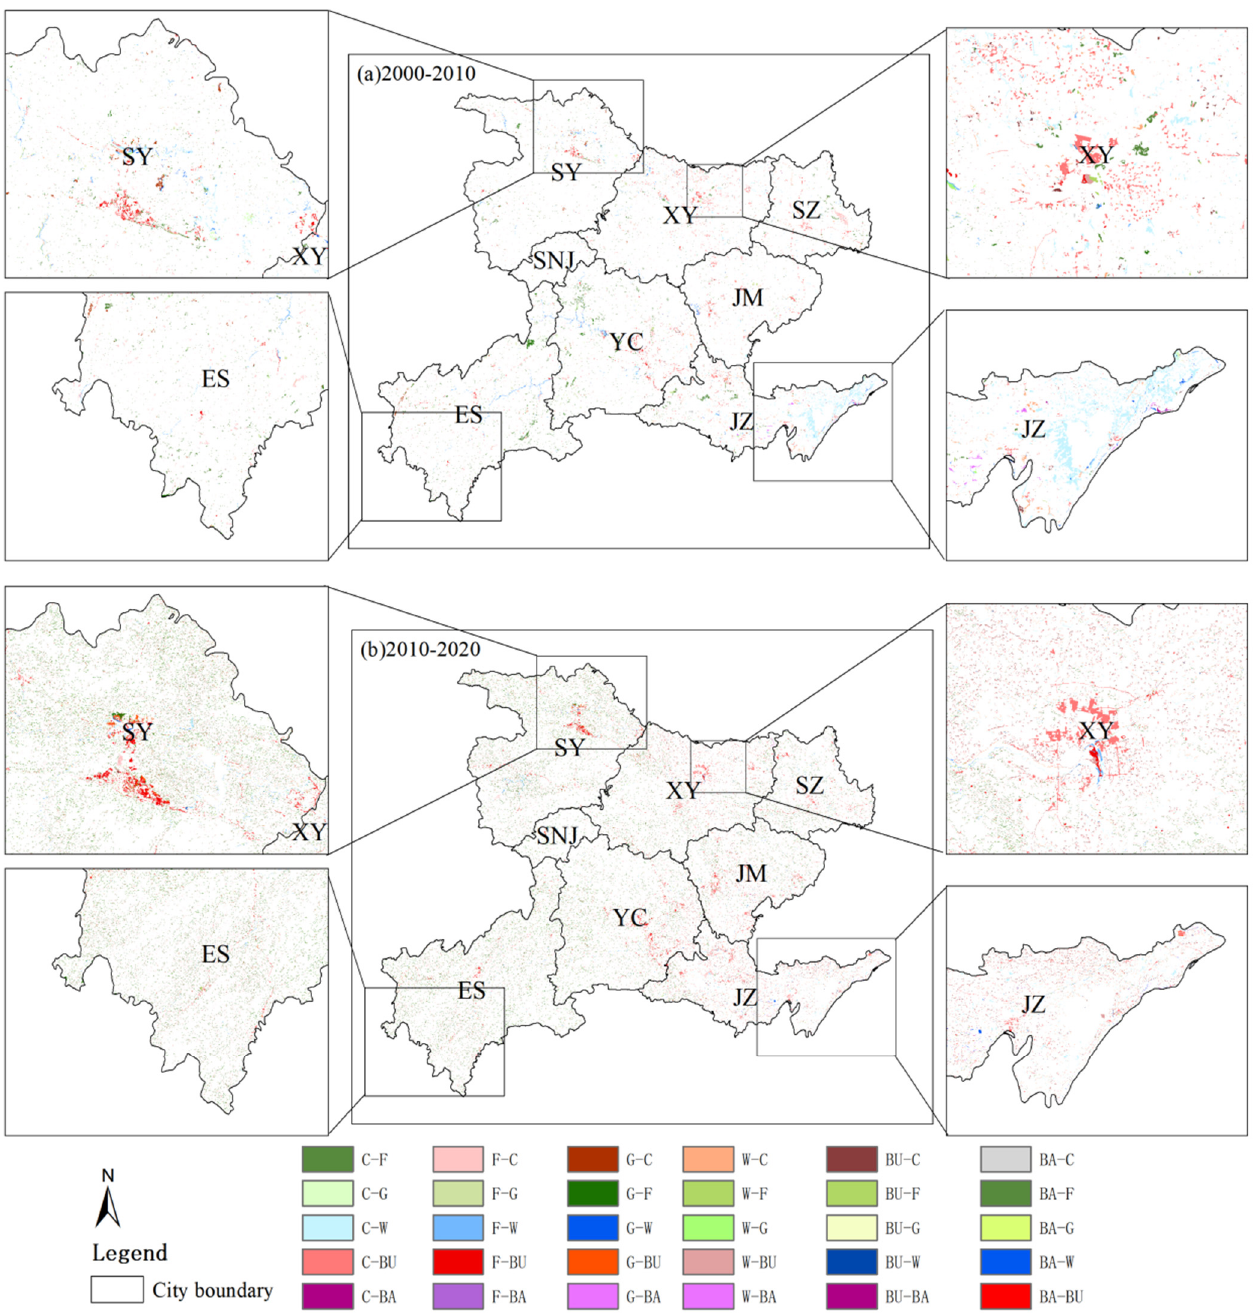
Figure 3. Land cover change in western Hubei Province from ( a ) 2000–2010 and ( b ) 2010–2020 (C—cropland, F—forestland, G—grassland, W—water basin, BU—built-up area, BA—bare; C-F means land cover from cropland to forestland).